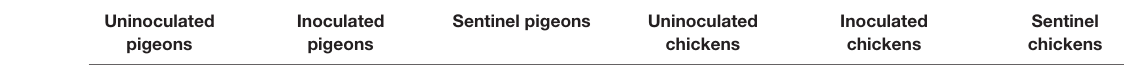
TABLE 3 | Mean corpuscular hemoglobin concentration of pigeons and chickens following inoculation with and/or exposure to a very virulent infectious bursal disease virus.